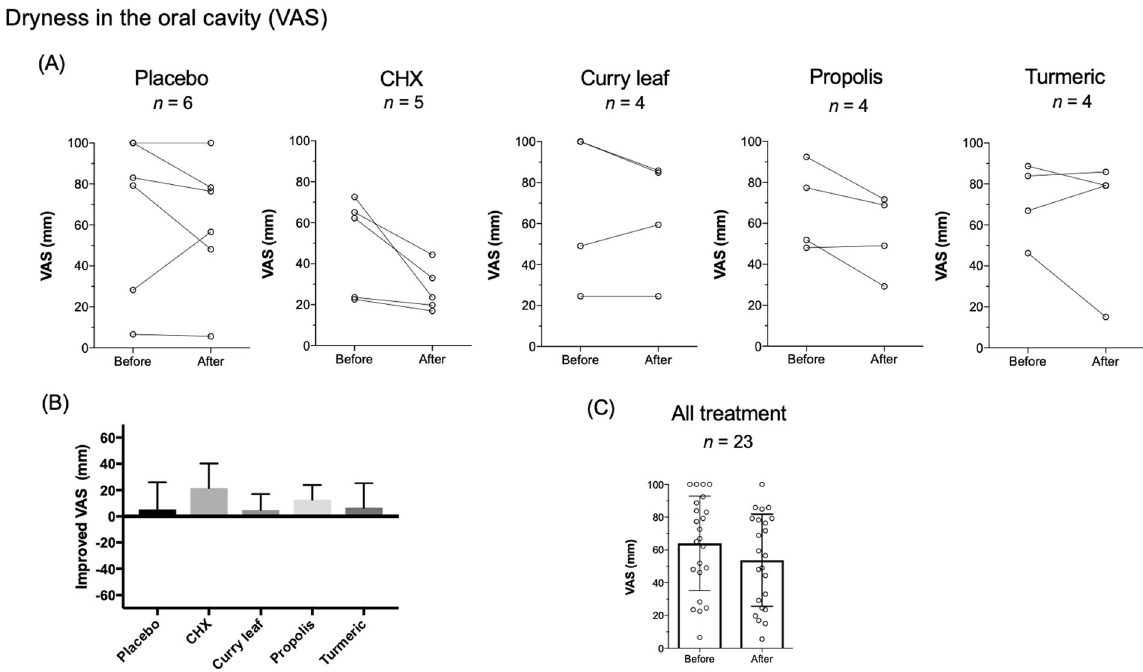
Fig. 3 Effect of intervention on dryness in the oral cavity. A Evaluation of dryness in the oral cavity in each group. The transition of the VAS of dryness (mm) in every patient before and after the intervention is denoted by circles and the connecting line. B Improved VAS of dryness (mm) between every group. C Evaluation of dryness in the oral cavity in all treatment group. The bar graph of VAS of dryness (mm) with average ± SD is shown. VAS scores of individual subjects ( n = 23) are also plotted in the